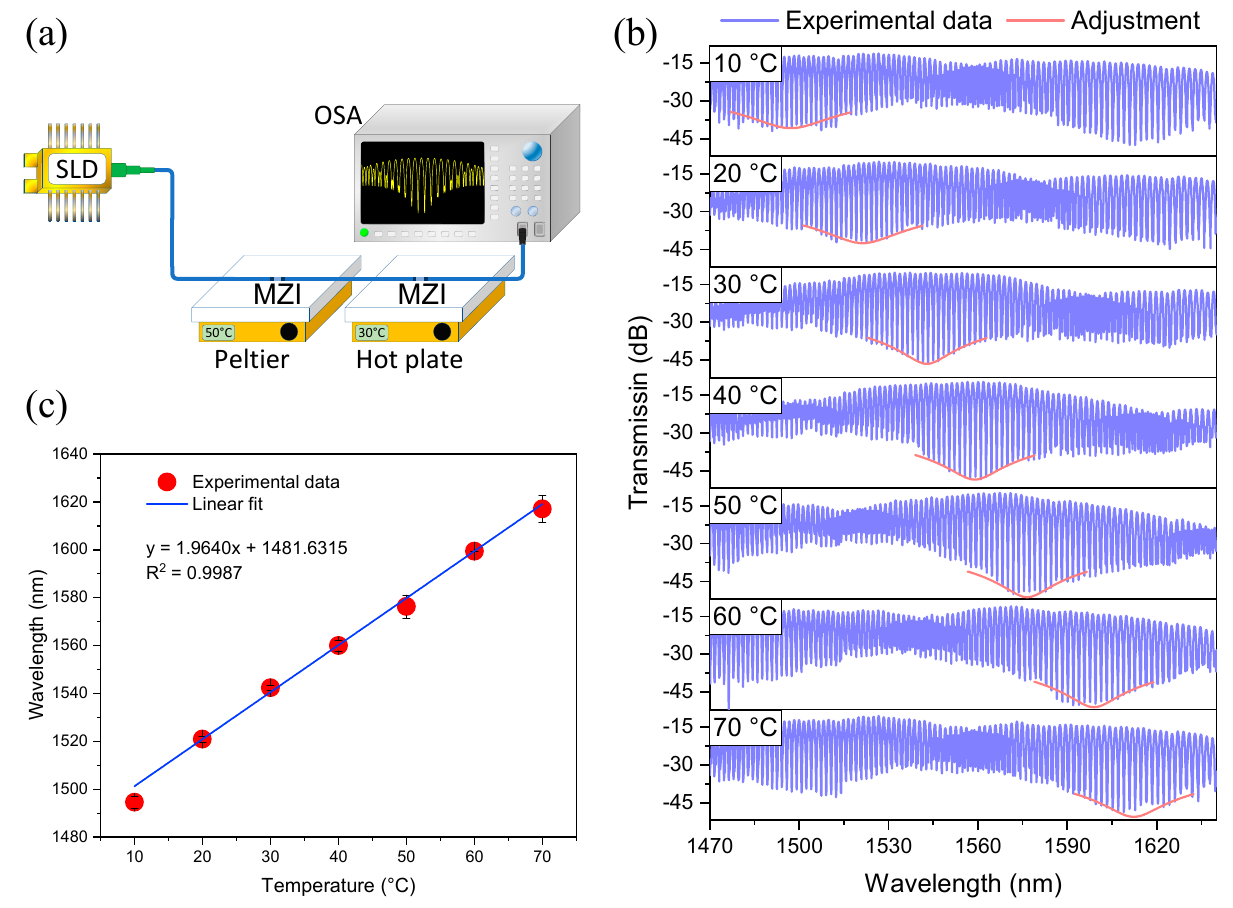
Figure 12. ( a ) Experimental setup for temperature measurement based on Vernier effect. ( b ) Experimental spectra of the two MZIs when the sensing MZI was at different temperatures, ( c ) Wavelength shift of one dip of the lower envelope as a function of temperature.